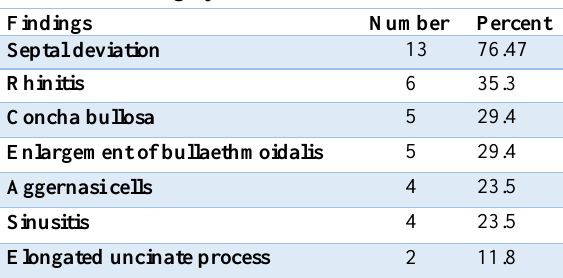
Table 1. ParanasalSinus CT Scan Findings in patients